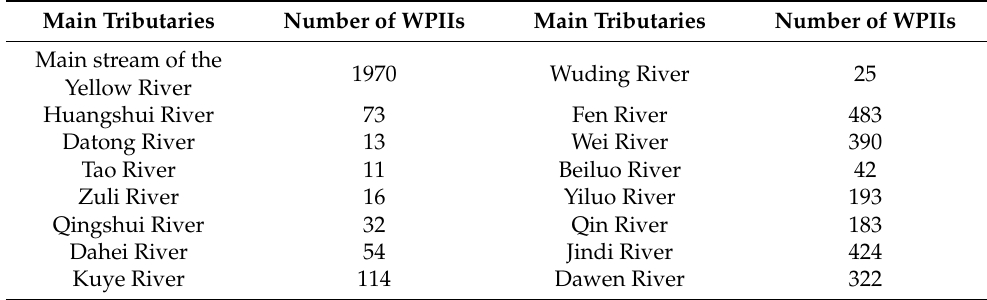
Table 2. Spatial relationship between WPIIs and rivers in 2013. Main Tributaries Number of WPIIs Main